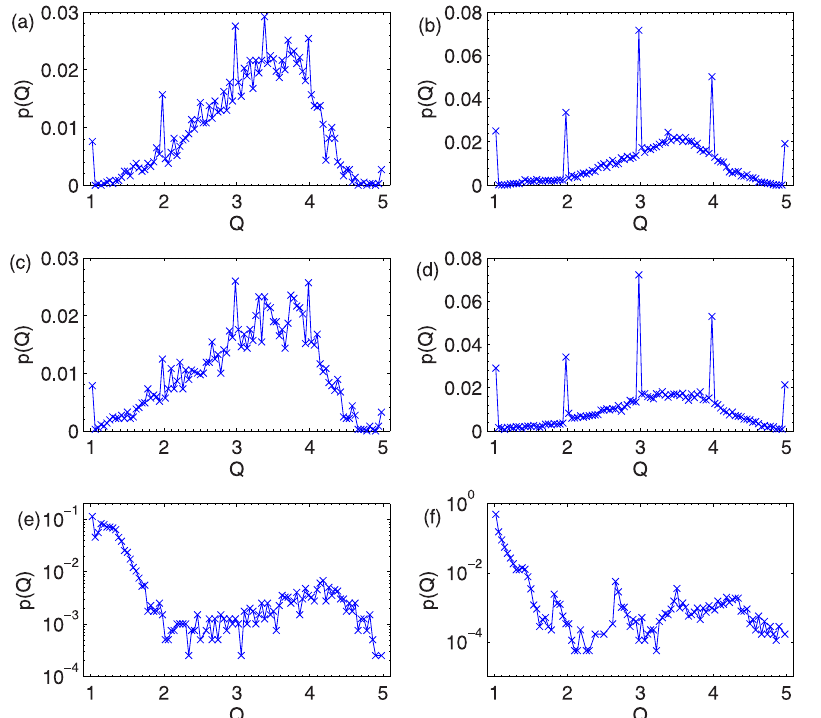
Figure 4. (a), (c) and (e) are the distribution of Q of the CR, IARR and IARR2 algorithms in Movielens data, respectively. (b), (d), (f) are the distribution of Q of the CR, IARR and IARR2 algorithms in Netflix data, respectively. h is set as 3 in both IARR and IARR2